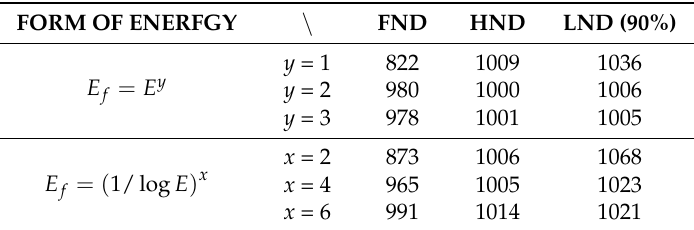
Table 6. Network lifetime with different forms of energy.